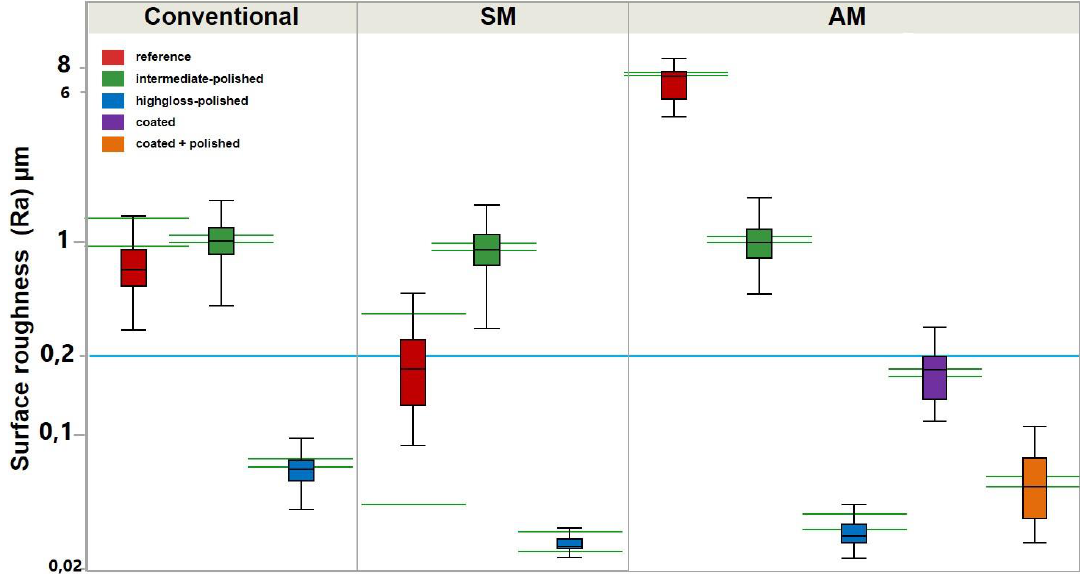
Figure 3. Surface roughness (R a ) of auto-polymerizing (conventional), milled (SM), and 3D printed (AM) denture base materials. The blue line represents the threshold of clinical relevance (0.2 µm). The green horizontal lines represent the confidential intervals for each dataset.